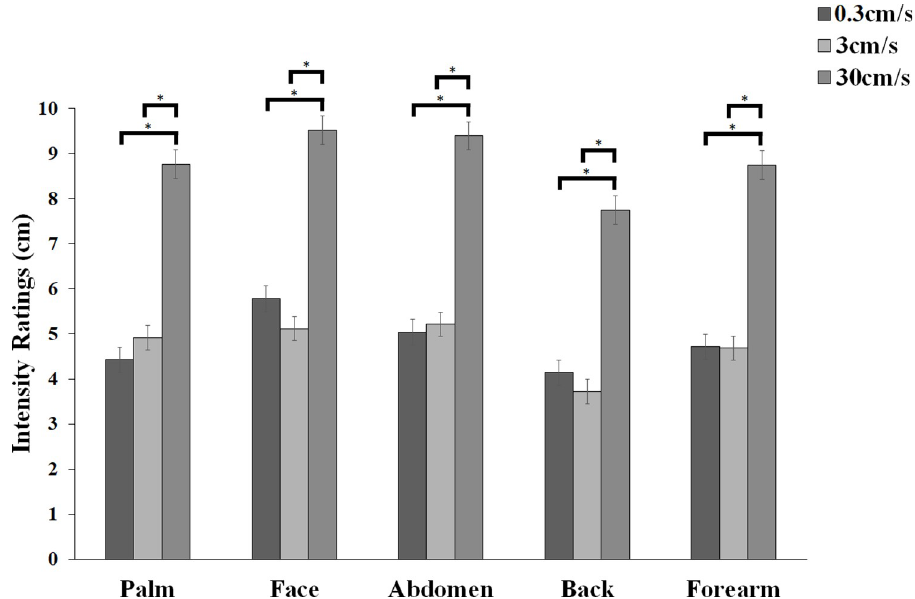
Fig 3. Mean intensity ratings (+/- s.e.m) for touch delivered at each of five body sites (palm, face (cheek), abdomen, back, forearm) at 3 cm/s (CT-optimal stroking) and 0.3 cm/s and 30 cm/s (non-CT optimal stroking)